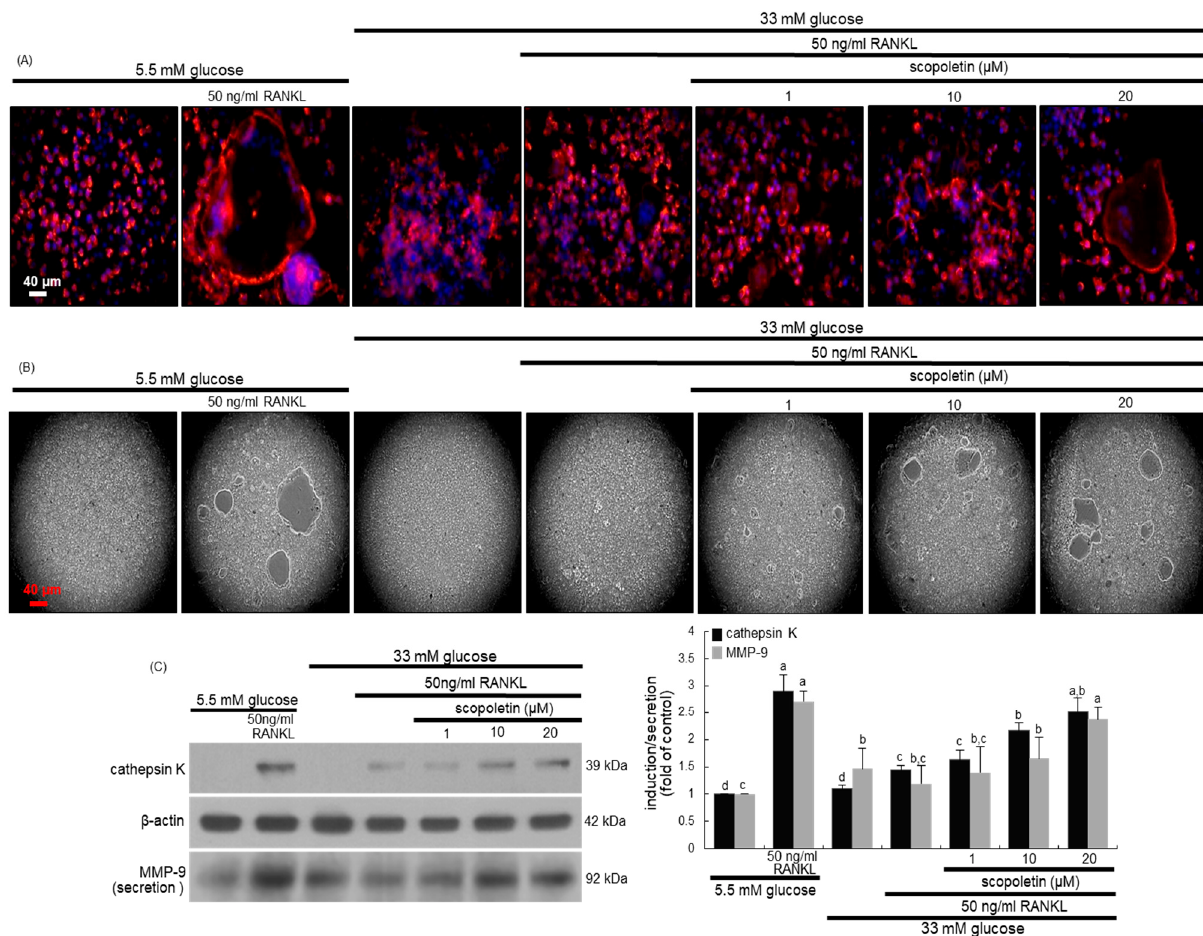
Figure 2. The inhibition of actin ring formation ( A ) and bone resorption ( B ), and cathepsin K induction and MMP-9 secretion ( C ) by scopoletin in glucose- and receptor activator of nuclear factor- κ B-ligand (RANKL)-exposed Raw 264.7 cells. Raw 264.7 cells were cultured in α -MEM containing 5.5 mM glucose or 33 mM glucose in the absence and presence of 50 ng/mL RANKL or 1–20 µ M scopoletin for five days. RANKL-differentiated cells were fixed, and rhodamine phalloidin was added to the fixed cells ( A ). Fluorescent images were taken with a fluorescence microscope. Bone resorption of Raw 264.7 cells-derived osteoclasts was assayed using a resorption assay kit ( B ). The resorbed pits on the plate were visualized under light microscopy. Original magnification of microscopic images ( n = 6). Scale bar = 40 µ m. Cell lysates and media were subject to Western blot analysis with a primary antibody against cathepsin K and MMP-9 ( C ). Representative blot data were obtained from three independent experiments, and β -actin protein was used as an internal control. The values in bar graphs (mean ± SEM, n = 4) not sharing a small letter are different at p <